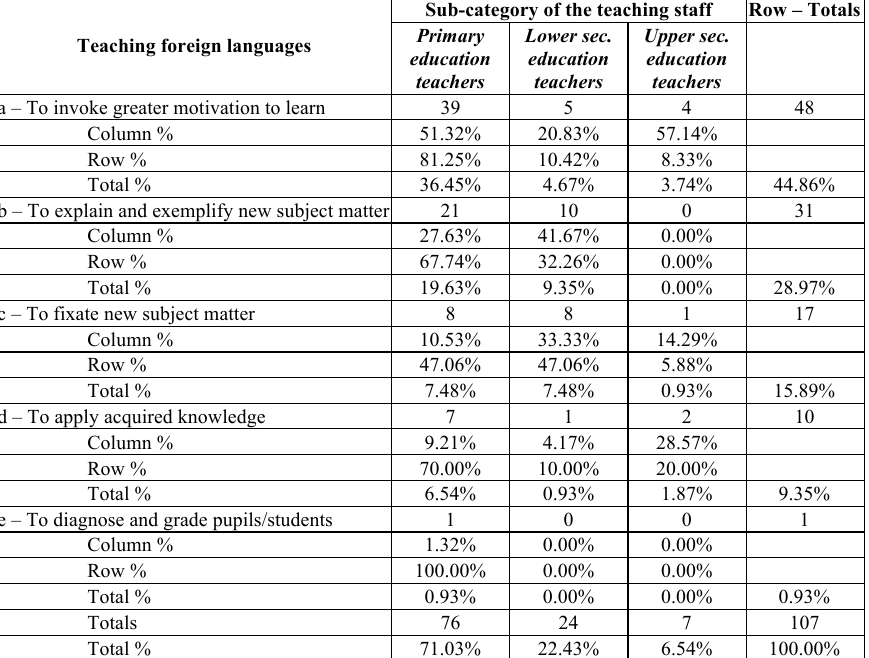
Table 3. Contingency table of the frequencies of the particular responses recorded at the stated question according to the factor sub-category of the teaching staff Teaching foreign